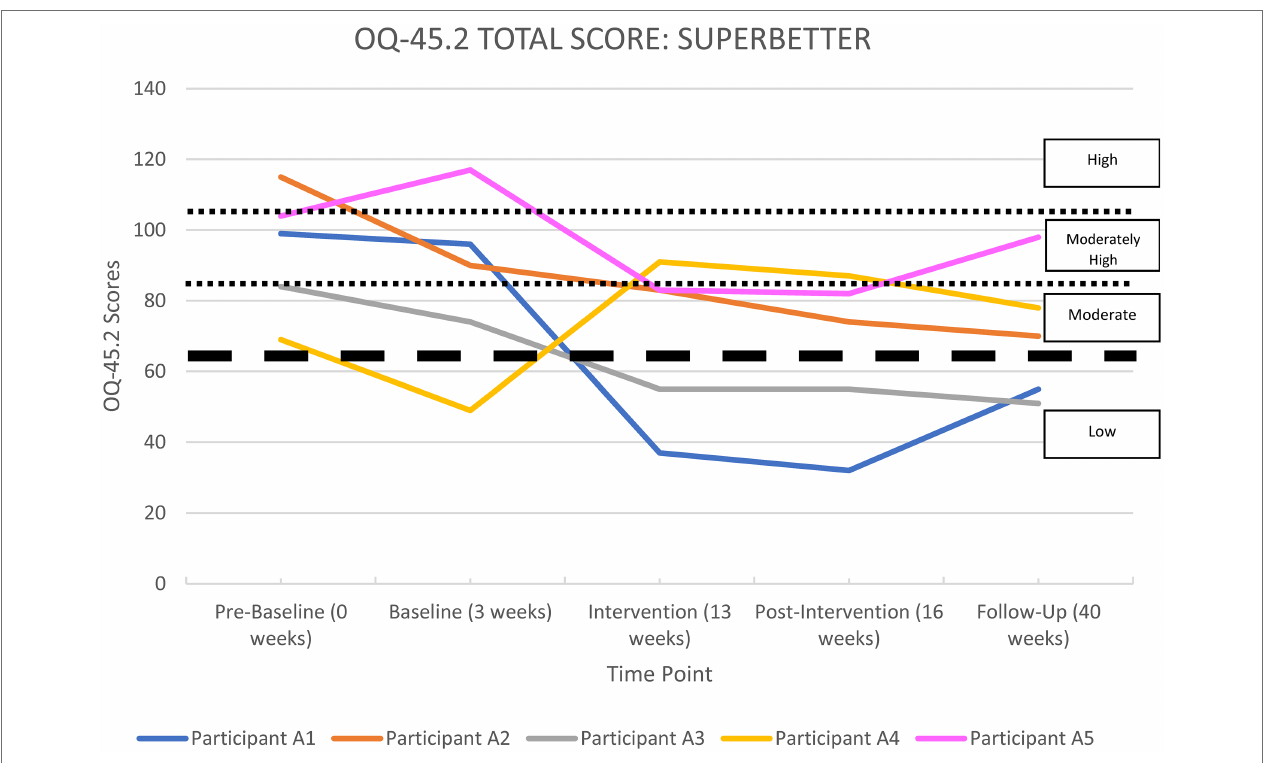
FIGURE 2 | OQ-45.2 total scores for SuperBetter